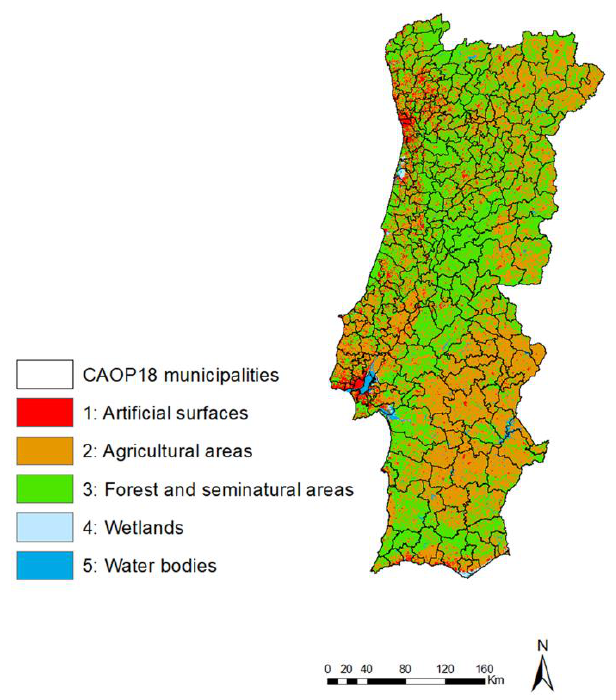
Figure 1. CORINE Land Cover of 2018 (level 1) distribution in Portugal, with municipal boundary definition (Carta Administrativa Oficial de Portugal: CAOP 2018).